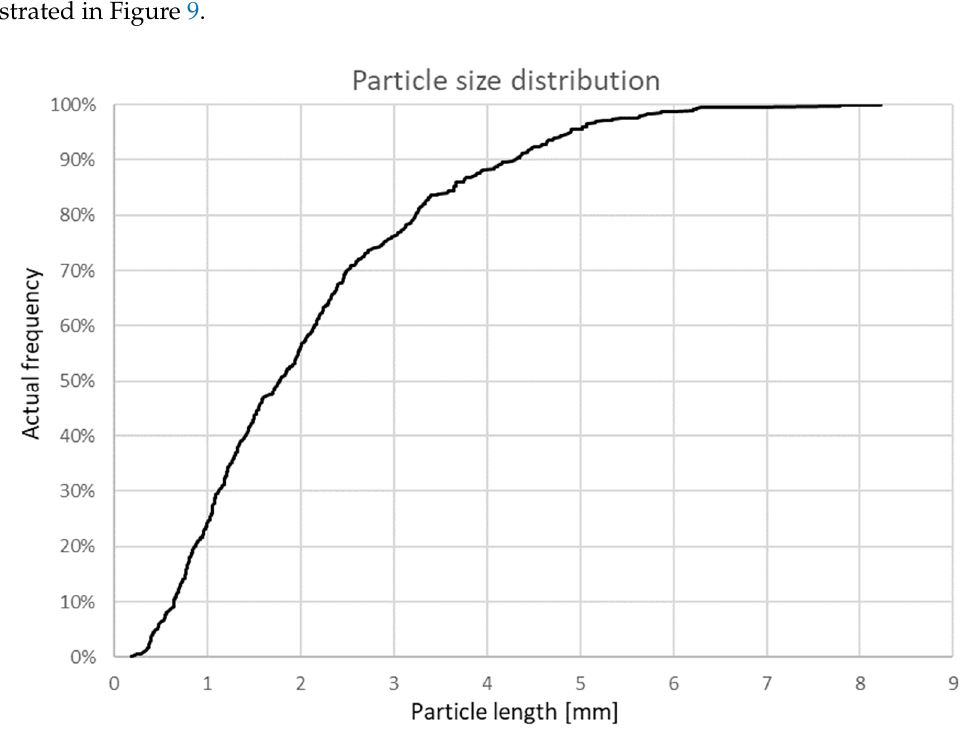
Figure 9. Particle size distribution of the wood material used in composites.